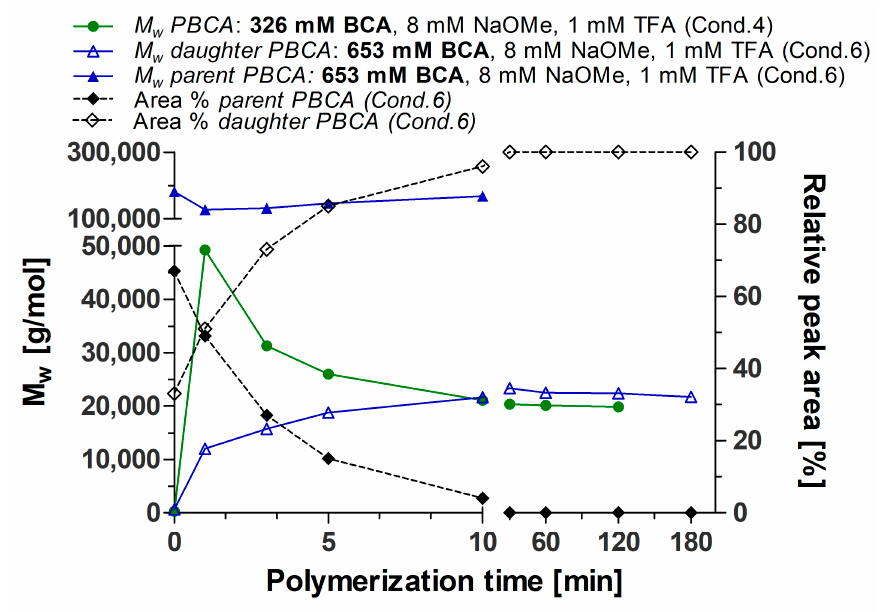
Figure 6. Influence of BCA amount on MW changes during the polymerization process. Comparison between 326 mM BCA and 653 mM BCA, both with 1 mM TFA and 8 mM NaOMe. MW was determined by